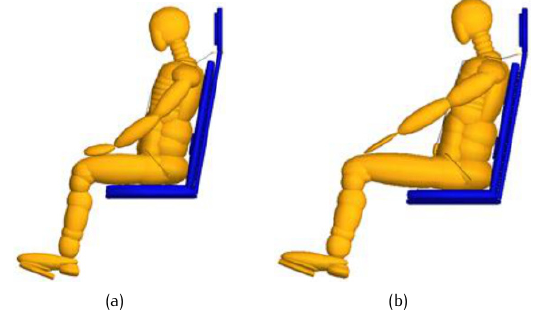
Figure 7. MADYMO models of seat, cushion, ATD, and seat belt for vertical test configuration for (a) 50 th -percentile dummy and (b) 95 th -percentile dummy.